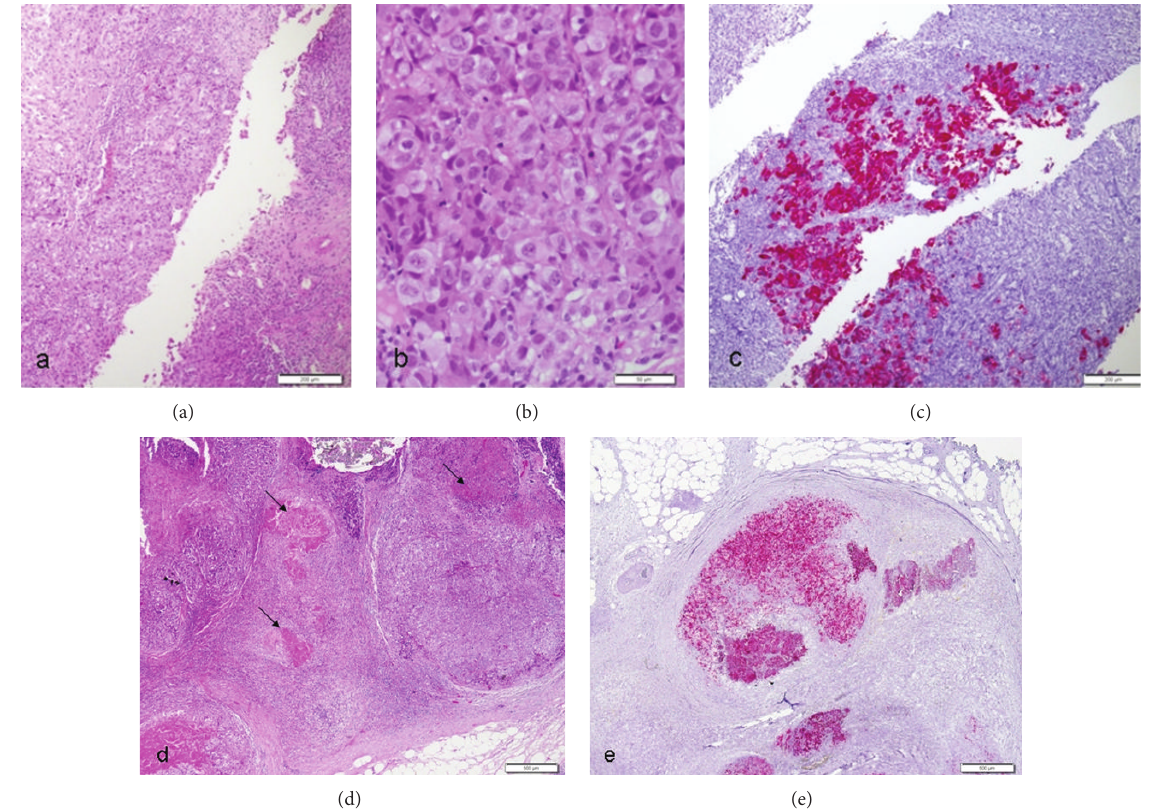
Figure3:Lowmagnification(a)andhighmagnification(b)sectionsfromthecoreneedlebiopsyshowedconnectivetissueandasmallamount of lymphoid tissue massively infiltrated by a malignant process composed of large, atypical cells with eosinophilic cytoplasm, vesicular nuclei with prominent nucleoli (hematoxylin and eosin). MART-1 immunostain confirmed the diagnosis of metastatic melanoma (c). In the resected specimen, lymph nodes matted together were almost completely replaced by metastatic melanoma with extensive areas of necrosis (arrows) ((d), low magnification, hematoxylin and eosin; (e), confirmatory MART-1